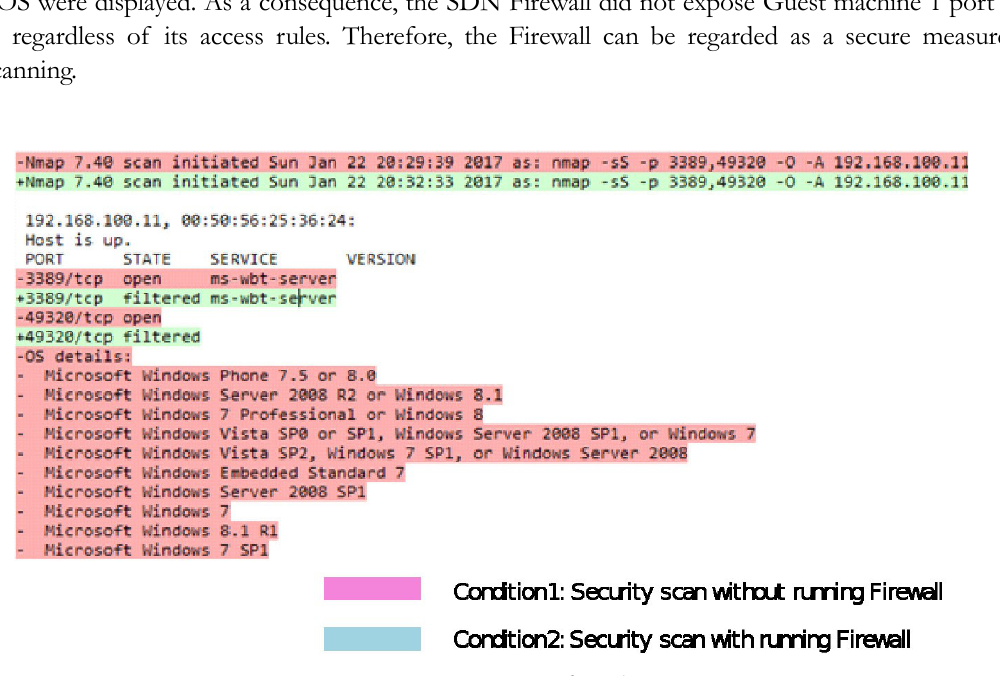
Figure 9. Comparison of